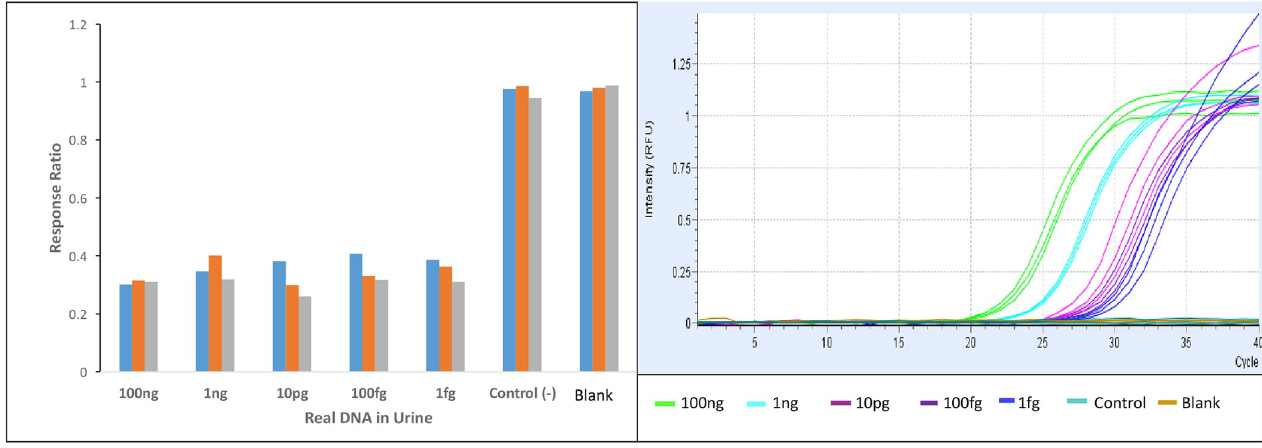
Fig 8. (A) Three "Spikes" urines were evaluated containing 100 ng, 1 ng, 10 pg, 100 fg and 1 fg of MTB DNA. It was compared with real time